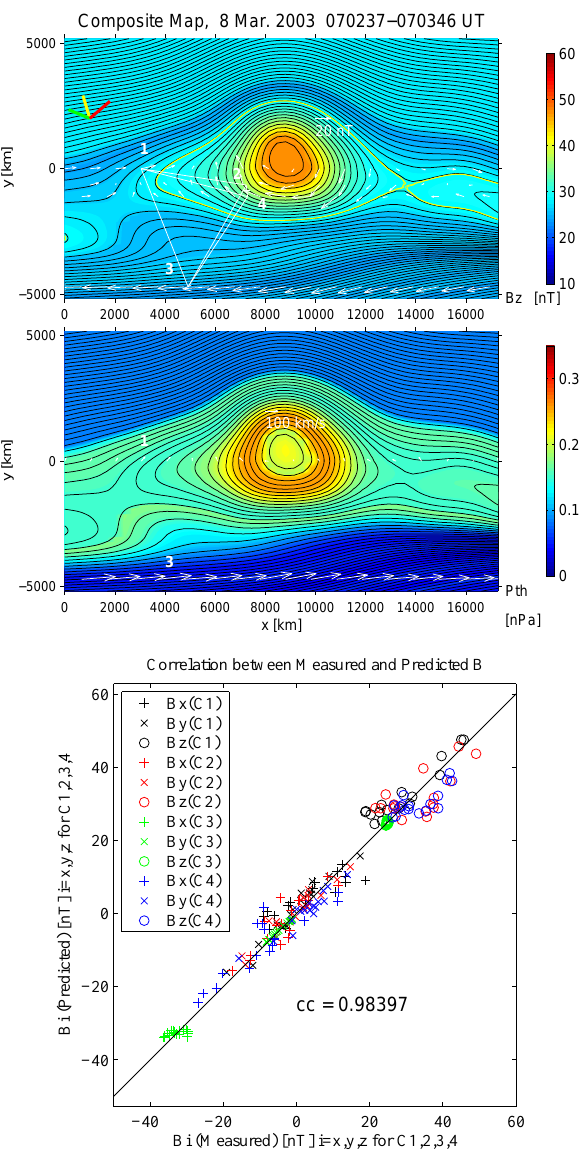
Fig. 4. Field and pressure maps and associated scatter plot for FTE 1. The format is the same as in Fig.